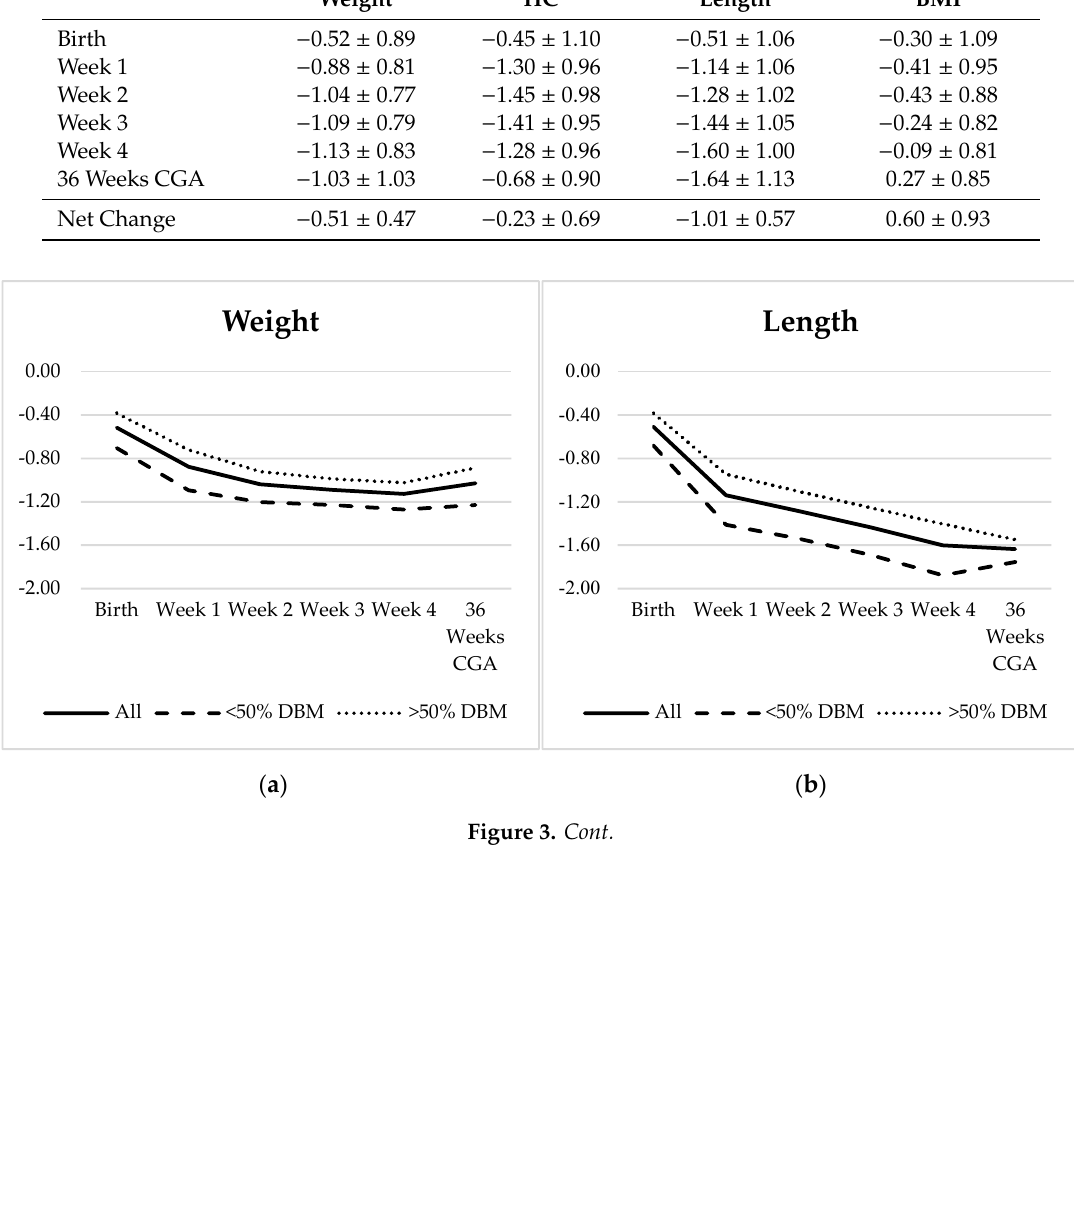
Table 5. z-scores of anthropometric measurements each week and at 36 weeks corrected gestational age (CGA). Mean ±